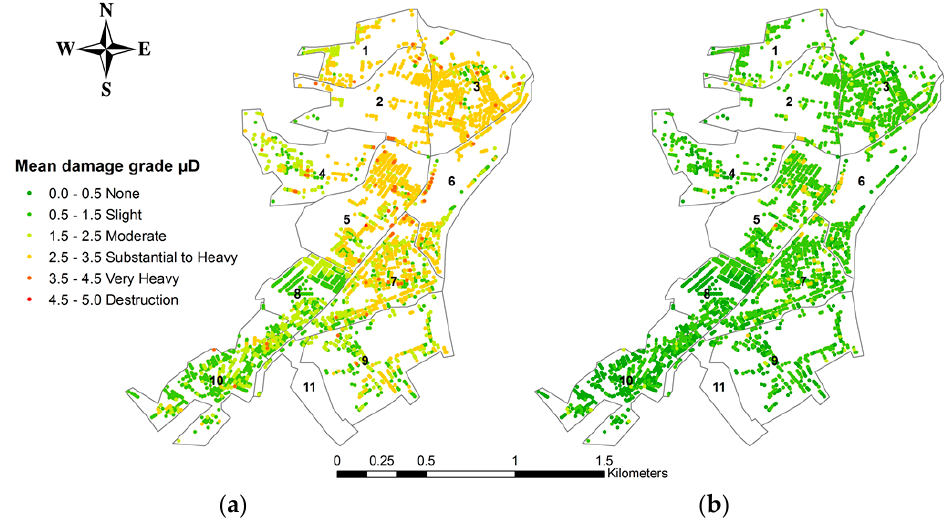
Figure 9. Mean damage grade for the residential buildings of Imzouren according to ( a ) the deterministic scenario and ( b) the probabilistic scenario.